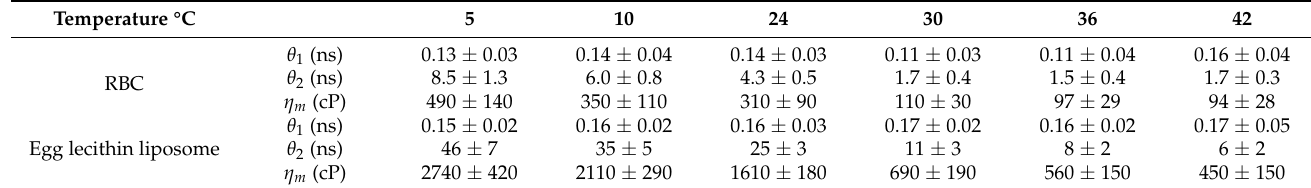
Table 1. Correlation times θ 1 and θ 2 , and membrane microviscosity ( η m ) of RBCs and egg yolk lecithin liposomes assessed at different temperatures by studying the anisotropy of PKH26 fluorescence. Anisotropy curves were analyzed by the associated decay approach; θ 1 corresponds to the rotational diffusion of free unbound PKH26, θ 2 corresponds to the rotational diffusion of membrane-bounded PKH26